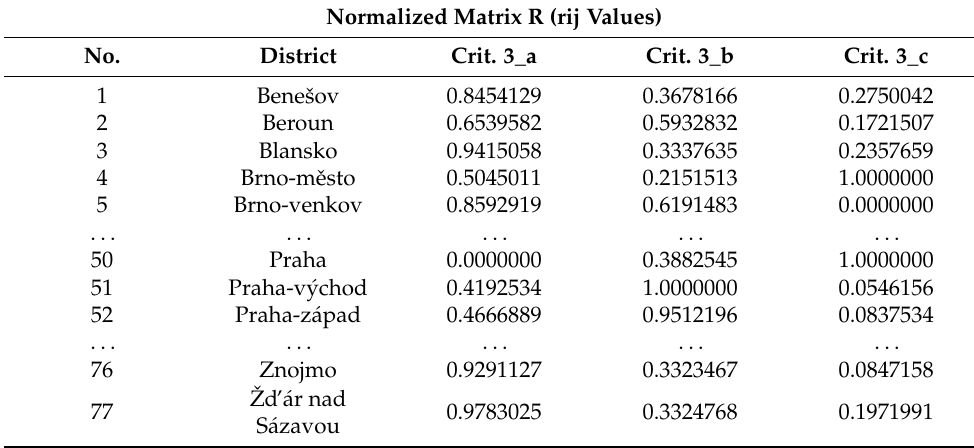
Table A3. Normalized matrix for 3rd area—selected